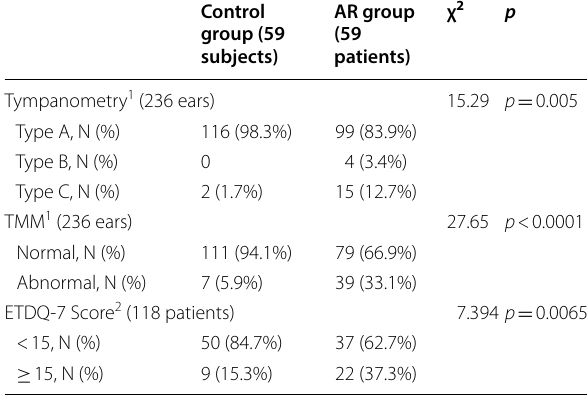
Table 3 Eustachian tube function for AR group and control